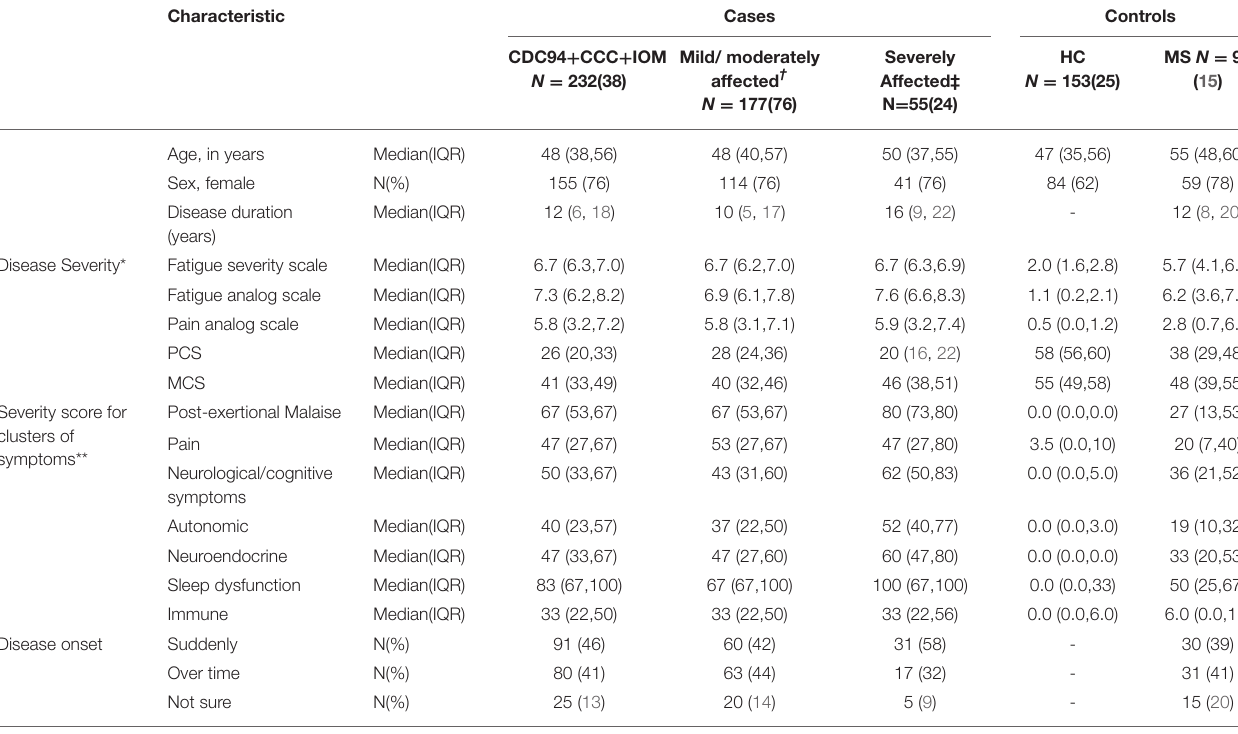
TABLE 1 | Characteristics of cases (both mild/moderately affected and severely affected) and controls (healthy controls and MS diseased controls) within UKMEB, with cases of ME/CFS defined using a combination of three diagnostic criteria: CDC-1994, CCC, and IOM.